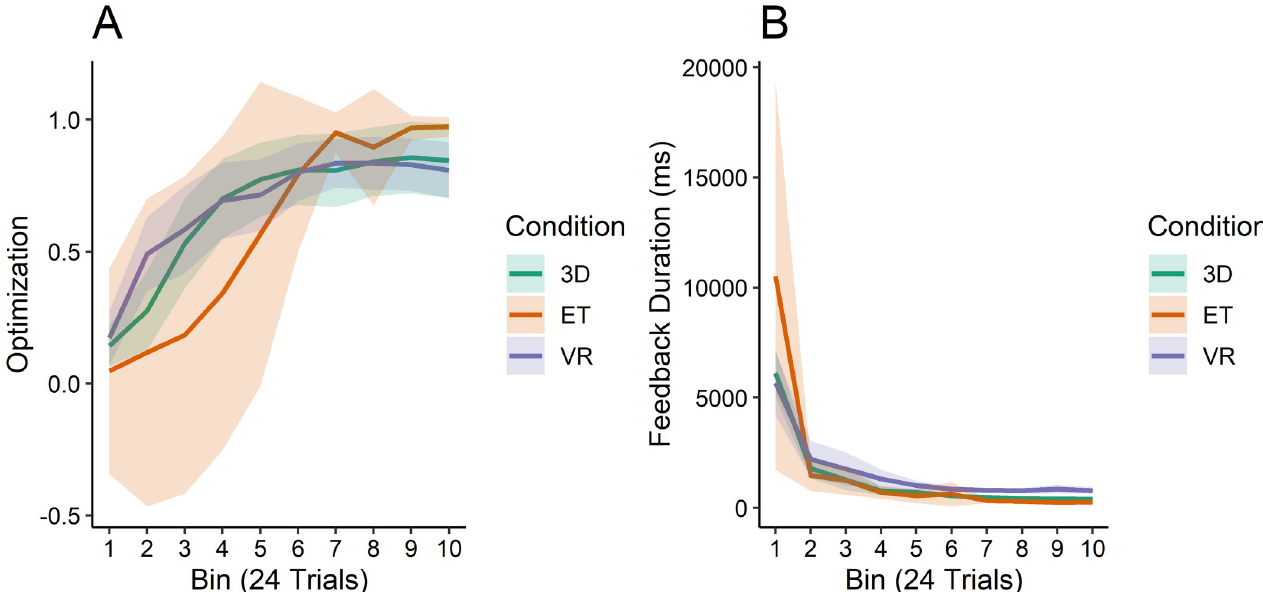
Fig 7. Attentional optimization and feedback duration by condition. (A) Information access optimization ranging from -1 to 1 (see text for calculation) and (B) time spent looking at feedback in between trials across 10 bins, measured in milliseconds, by condition.